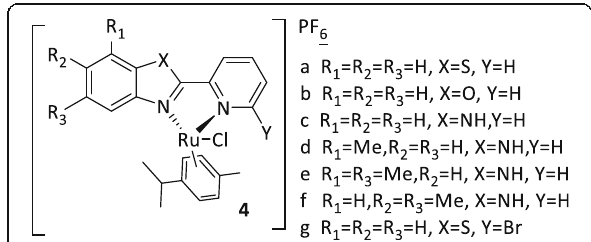
Fig. 43 Ru(II)-arene-BTZ, BOZ, BIZ complexes